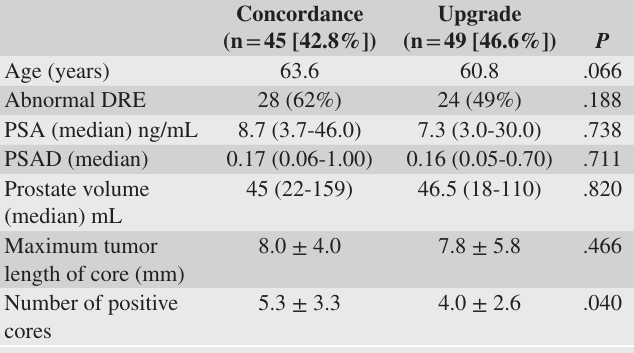
Table 3. Univariate Analysis of Possible Predictors for Concordance and Upgrade in the SB